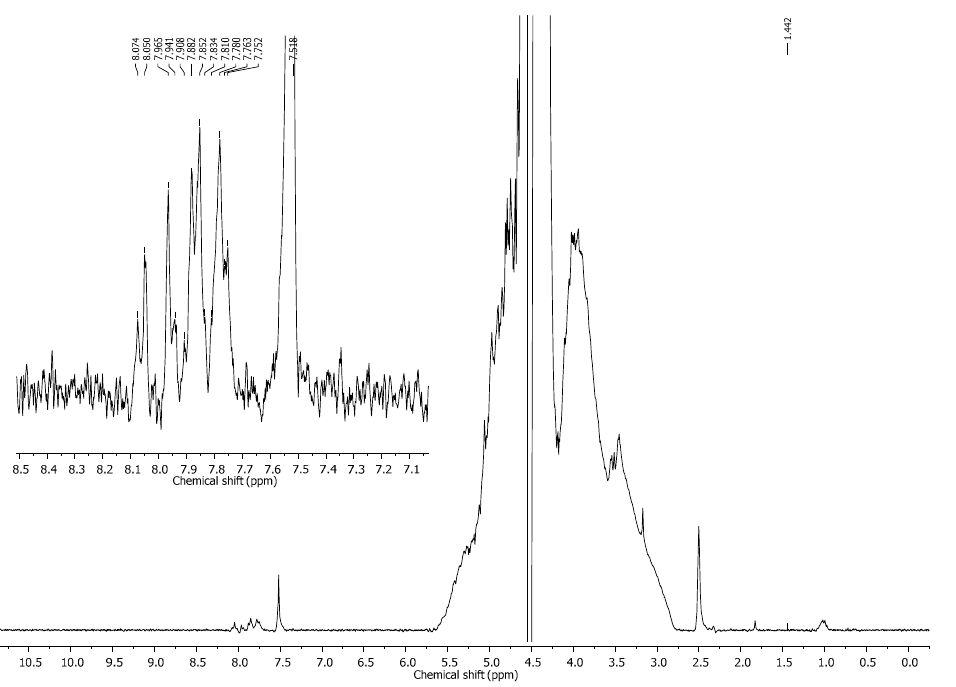
Figure 12. 1 H NMR spectrum recorded for a sample obtained from the experiment performed with System 4.